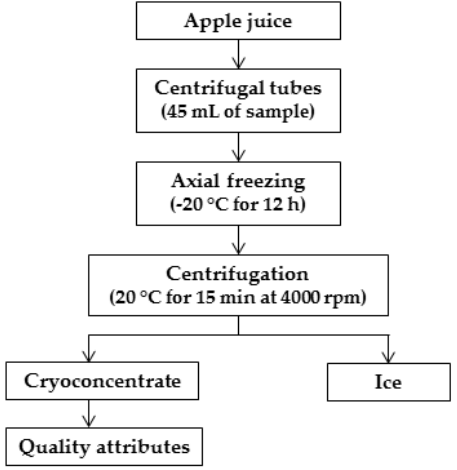
Figure 1. General centrifugal-assisted BCC experimental procedure.